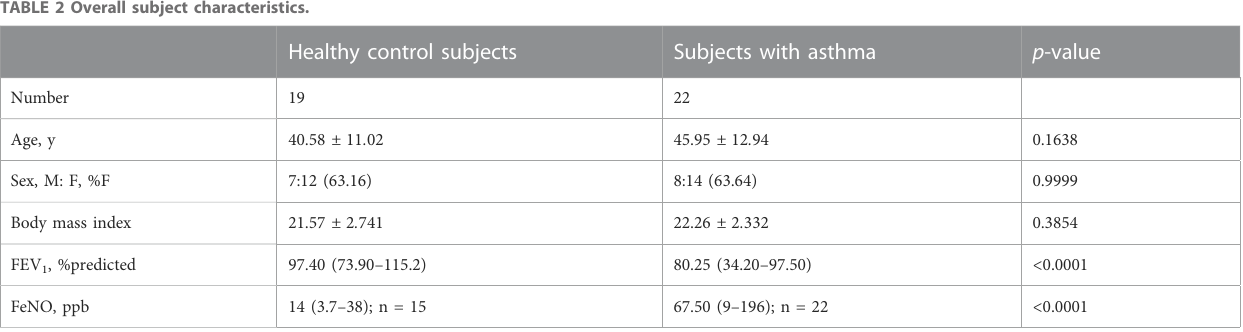
TABLE 2 Overall subject